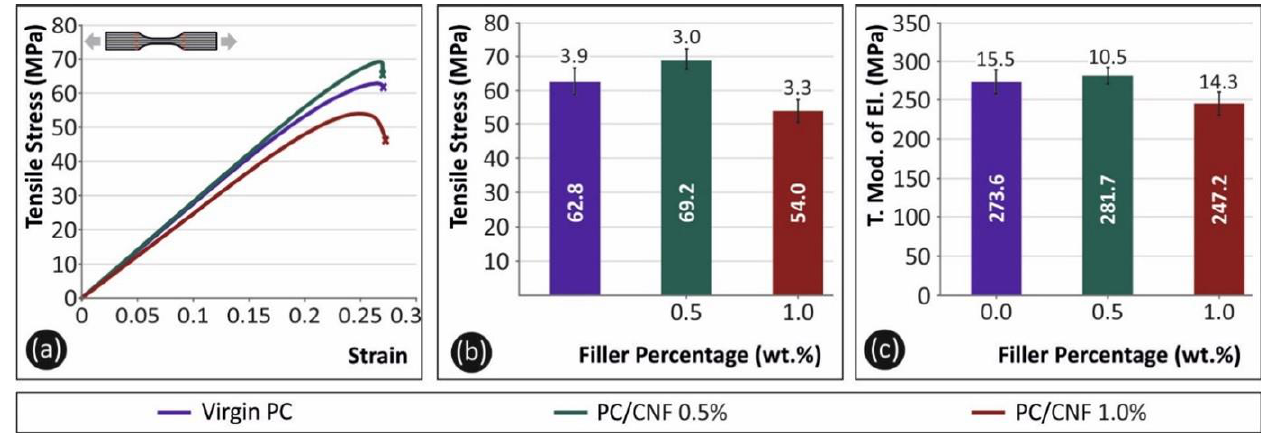
Figure 3. Tensile test results: ( a ) A representative stress (MPa) to strain curve for each tested material, ( b ) Average tensile strength (MPa) to filler concentration in the nanocomposites, ( c ) Average tensile modulus of elasticity (MPa) to the filler’s loading percentage.